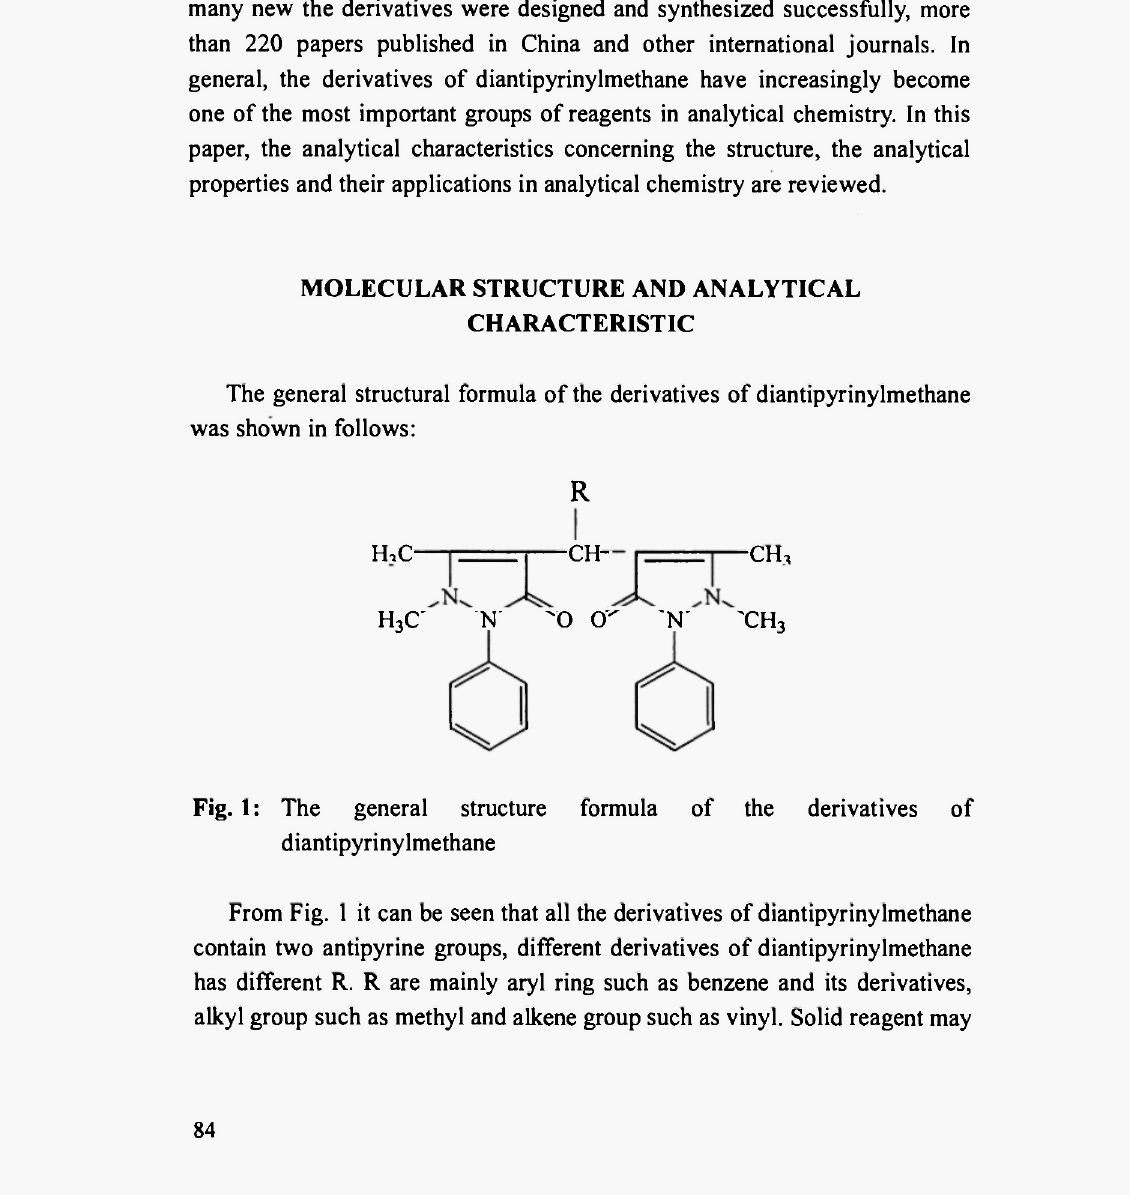
Fig. 1: The general structure formula of the derivatives of